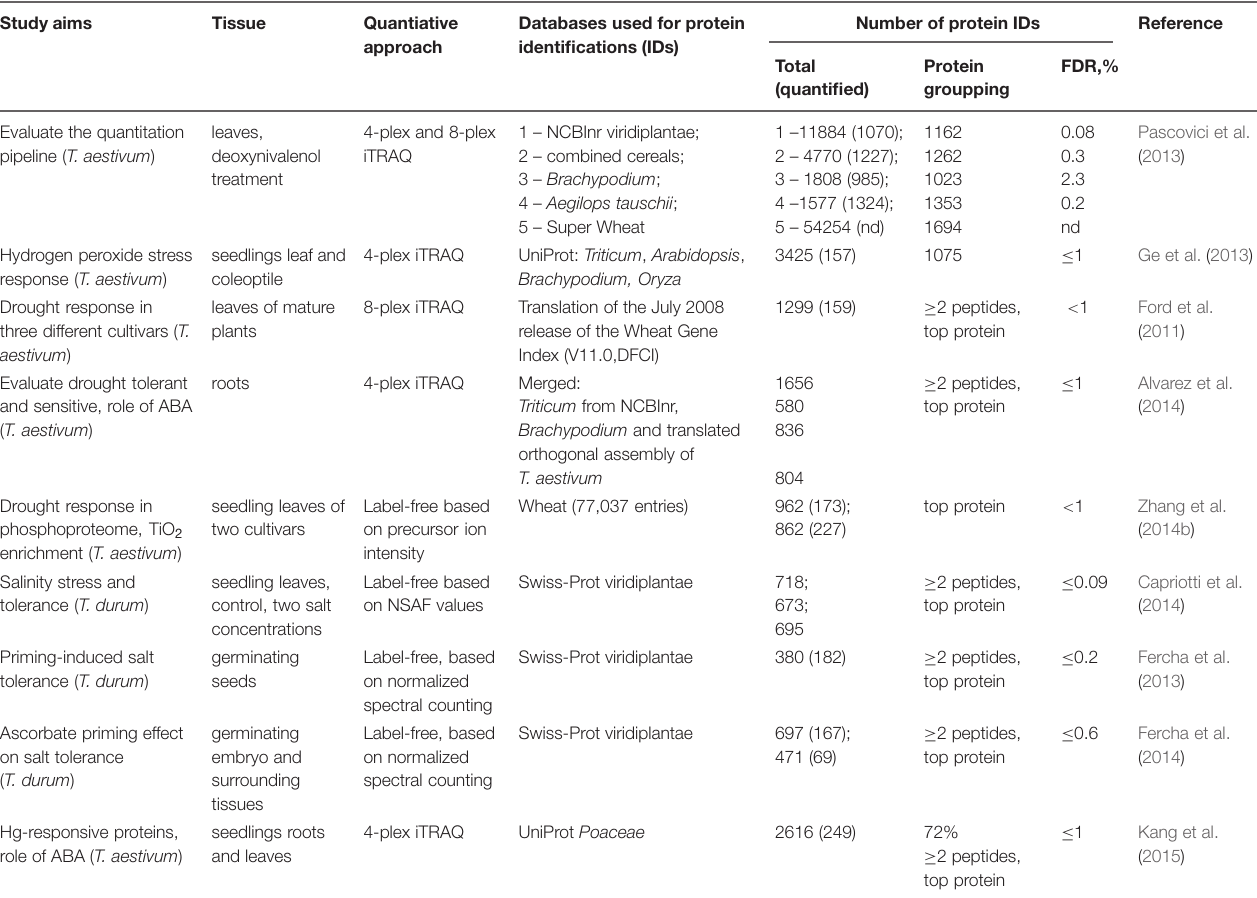
TABLE 2 | Recent large-scale gel-free quantitative proteomic studies on